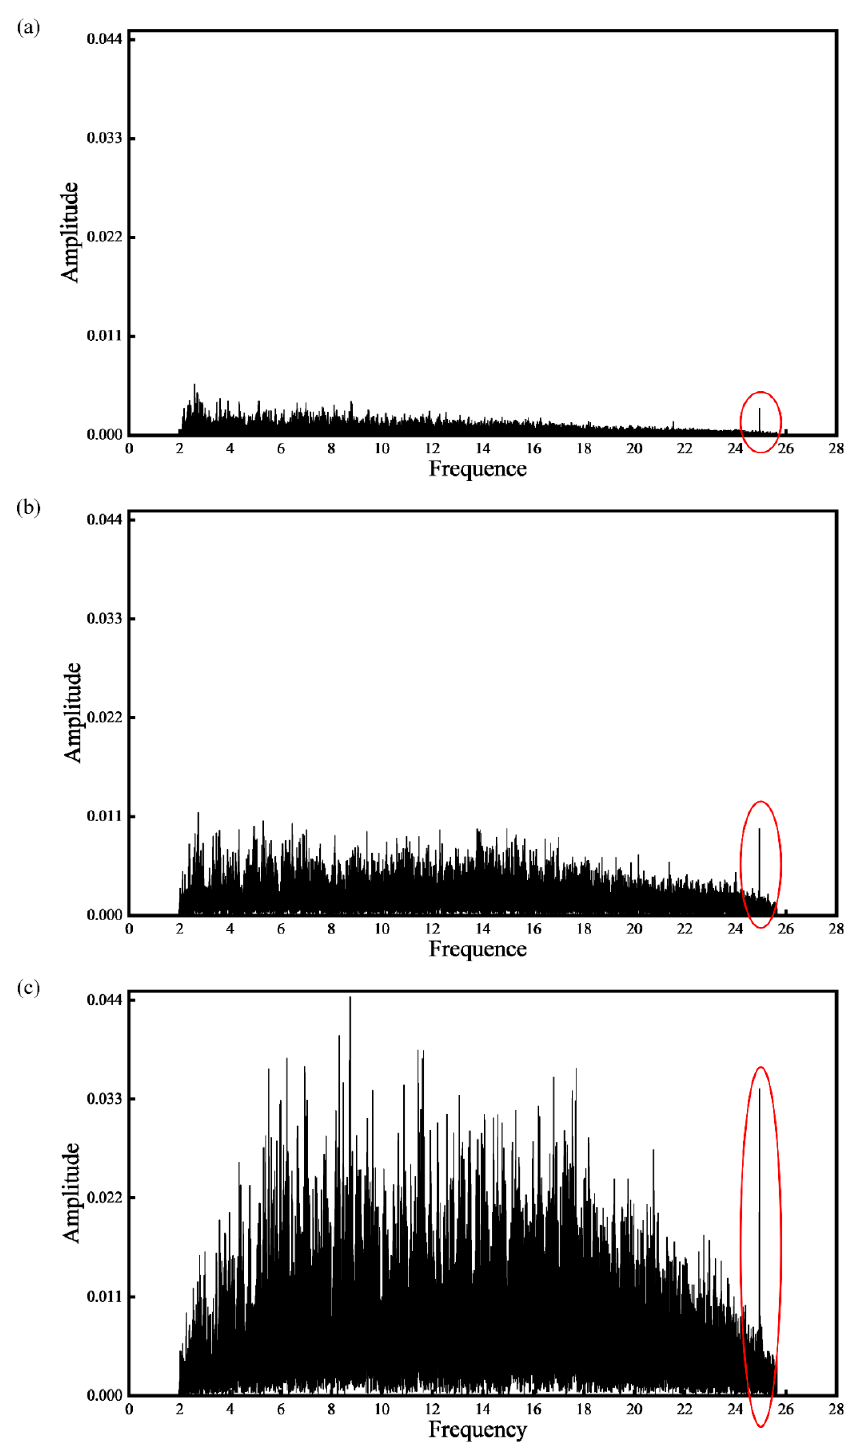
Figure 12. The frequency domain diagrams of sound signals with different laser powers: ( a ) 75 W;